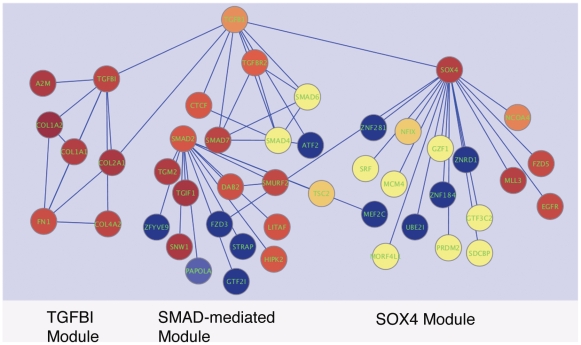
The SMAD2 mediated module (canonical TGF beta pathway), SOX4 module and TGFBI (GENE ID:7045) module of the TGF−β network.The expression ratios of GBM tissues to normal brain tissues are overlaid onto the network. Red color indicates over expression, yellow color indicates no changes, and blue color indicates under expression.